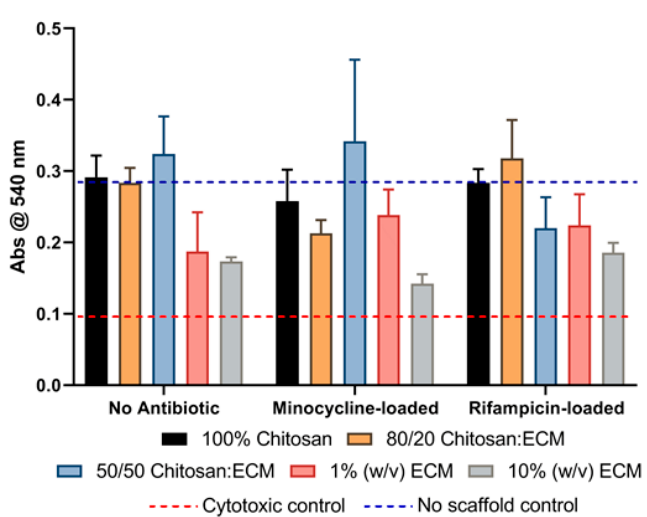
Figure 5. Graph showing the neutral red uptake by human microvascular endothelial cells exposed directly to the different scaffold formulations with and without antibiotics. Red line indicates the average neutral red uptake of cells exposed to ISO standard cytotoxic control, while the blue line shows the level of neutral red uptake in cells grown without scaffold exposure.